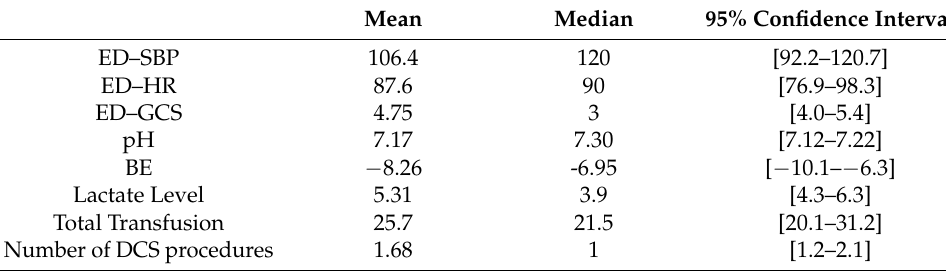
Figure 1. Charlson Comorbidity Index (CCI). Table 1. Relevant parameters during the prehospital and in-hospital evaluation.